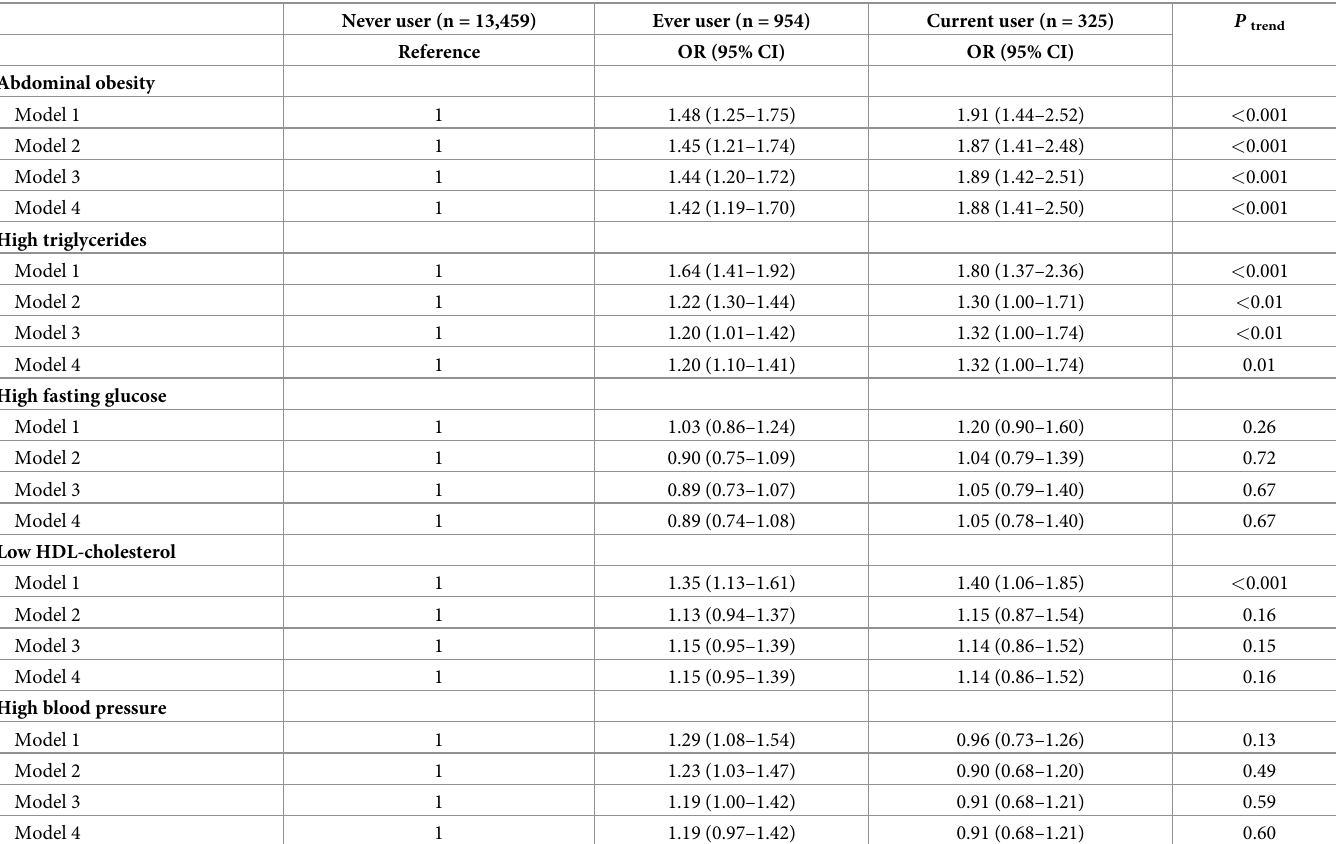
Table 2. Association between metabolic syndrome components and electronic cigarette exposure.